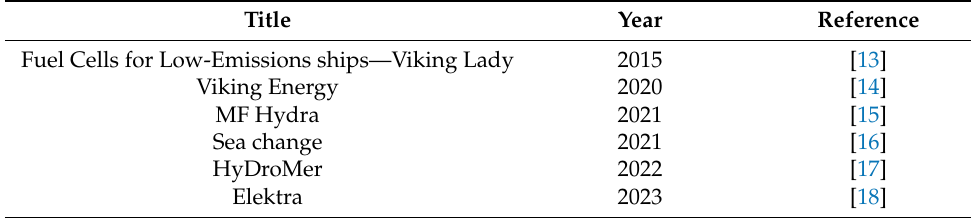
Table 1. Projects to apply fuel cells into the marine sector.